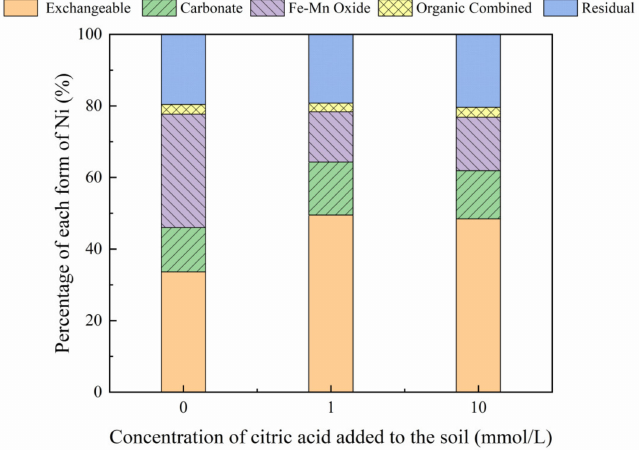
Figure 4. Distribution of different Ni forms in Ni-200 soil after the addition of citric acid (0, 1, 10 mmol/L).